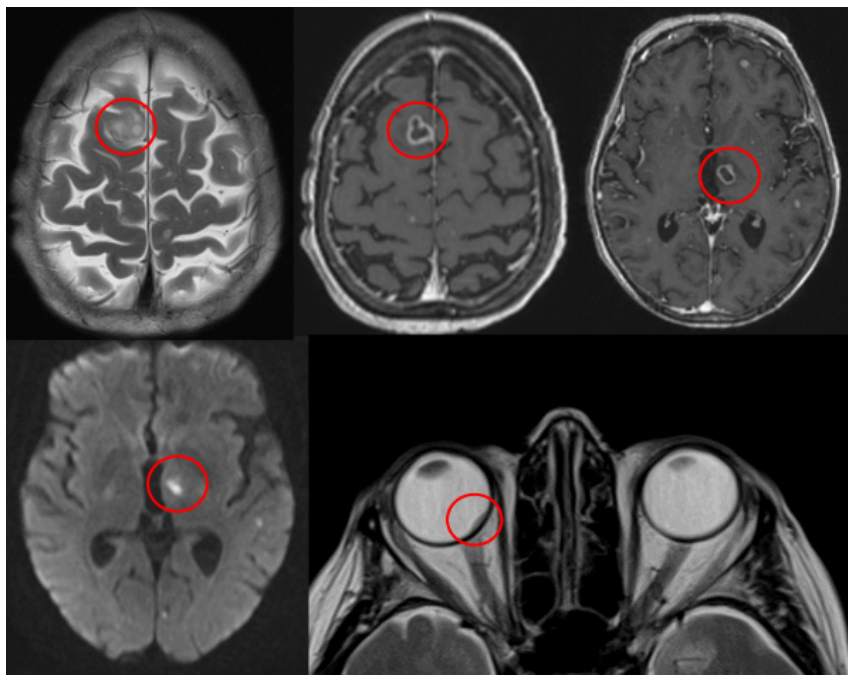
Figure 3: MRI brain showing disseminated cerebral nocardiosis and choroidal abscess